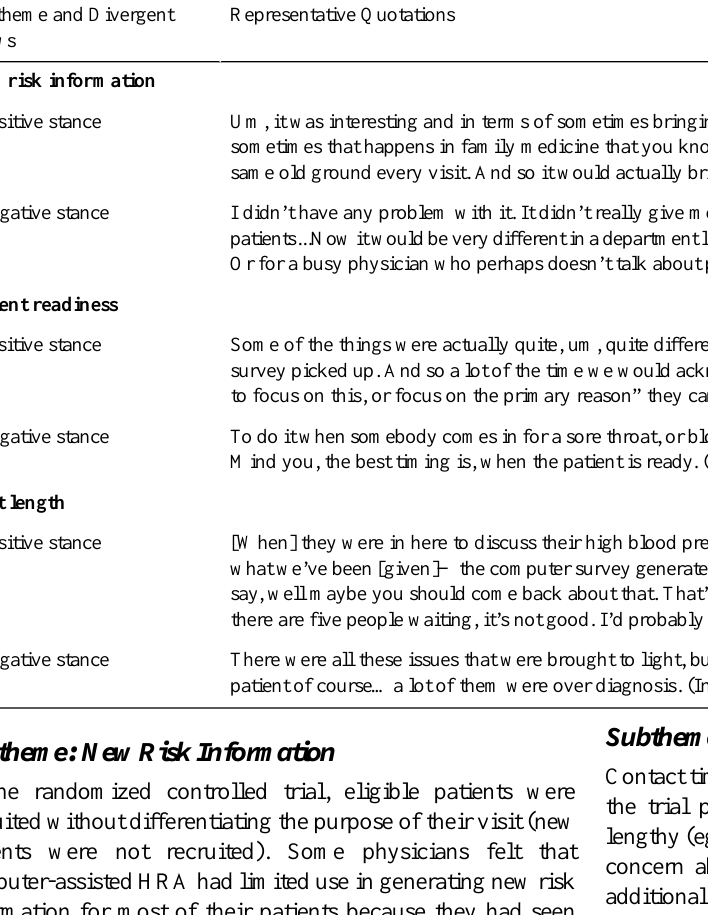
Representative QuotationsSubtheme and Divergent